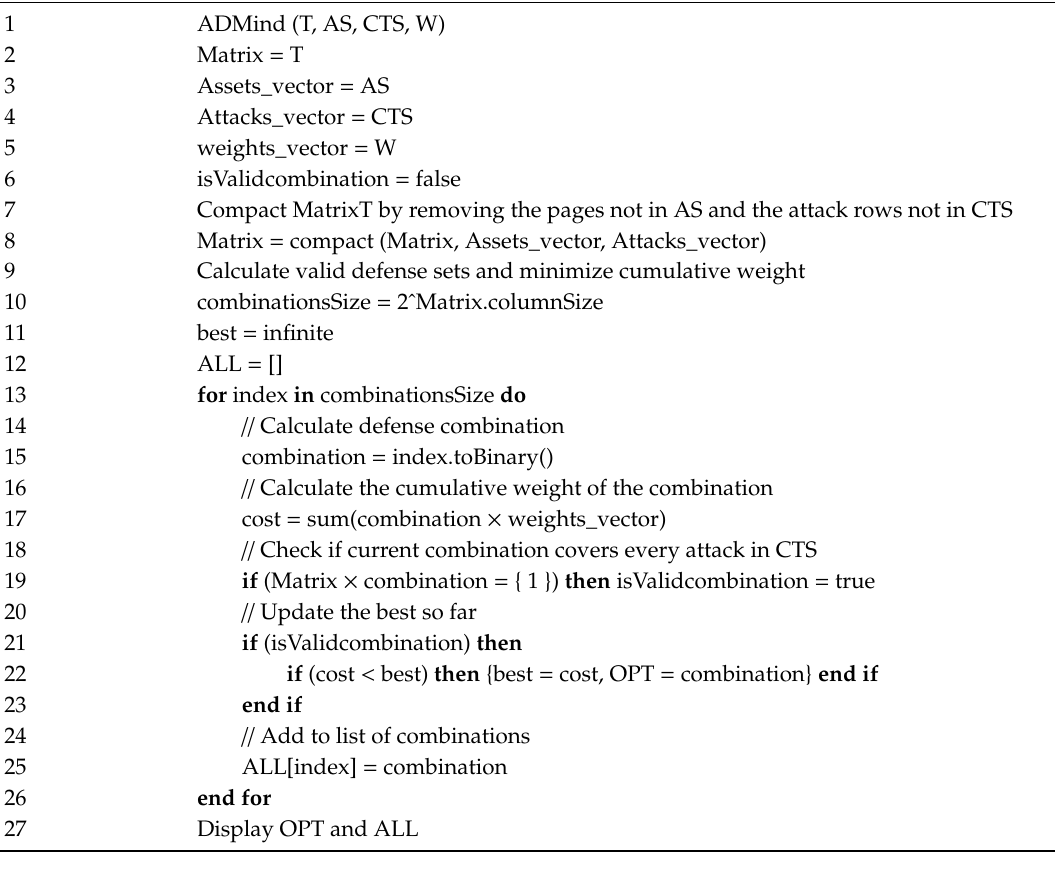
Algorithm 1. Finding the optimal defense set OPT covering the critical threat set CTS with minimum